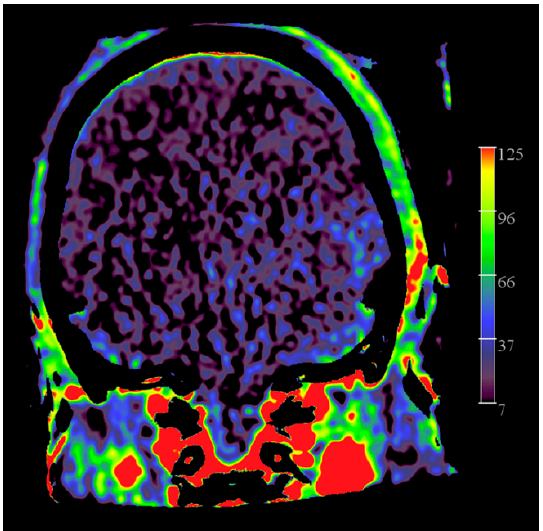
Figure 10. FD CT PBV imaging in a patient with no intracranial flow. Coronal PBV MIP reformation demonstrates filling of the ECA vascular territories, including middle meningeal artery, but no filling of pial arteries.